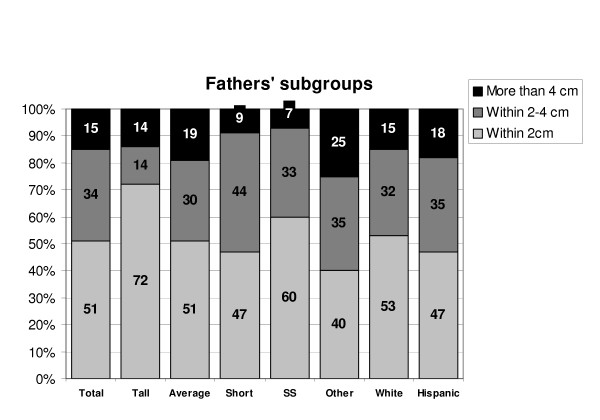
Subgroup analysis – fathers. Percentage of parents in each group who reported their heights accurately, moderately inaccurately and very inaccurately. Total: all groups, Tall: parents with height SDS of >1, Average: SDS -1 to 1, Short: SDS of <0, SS: parents of a child with chief complaint of short stature, Other: parents of a child with non-short stature complaint, White: white parents, Hispanic: Hispanic parents.